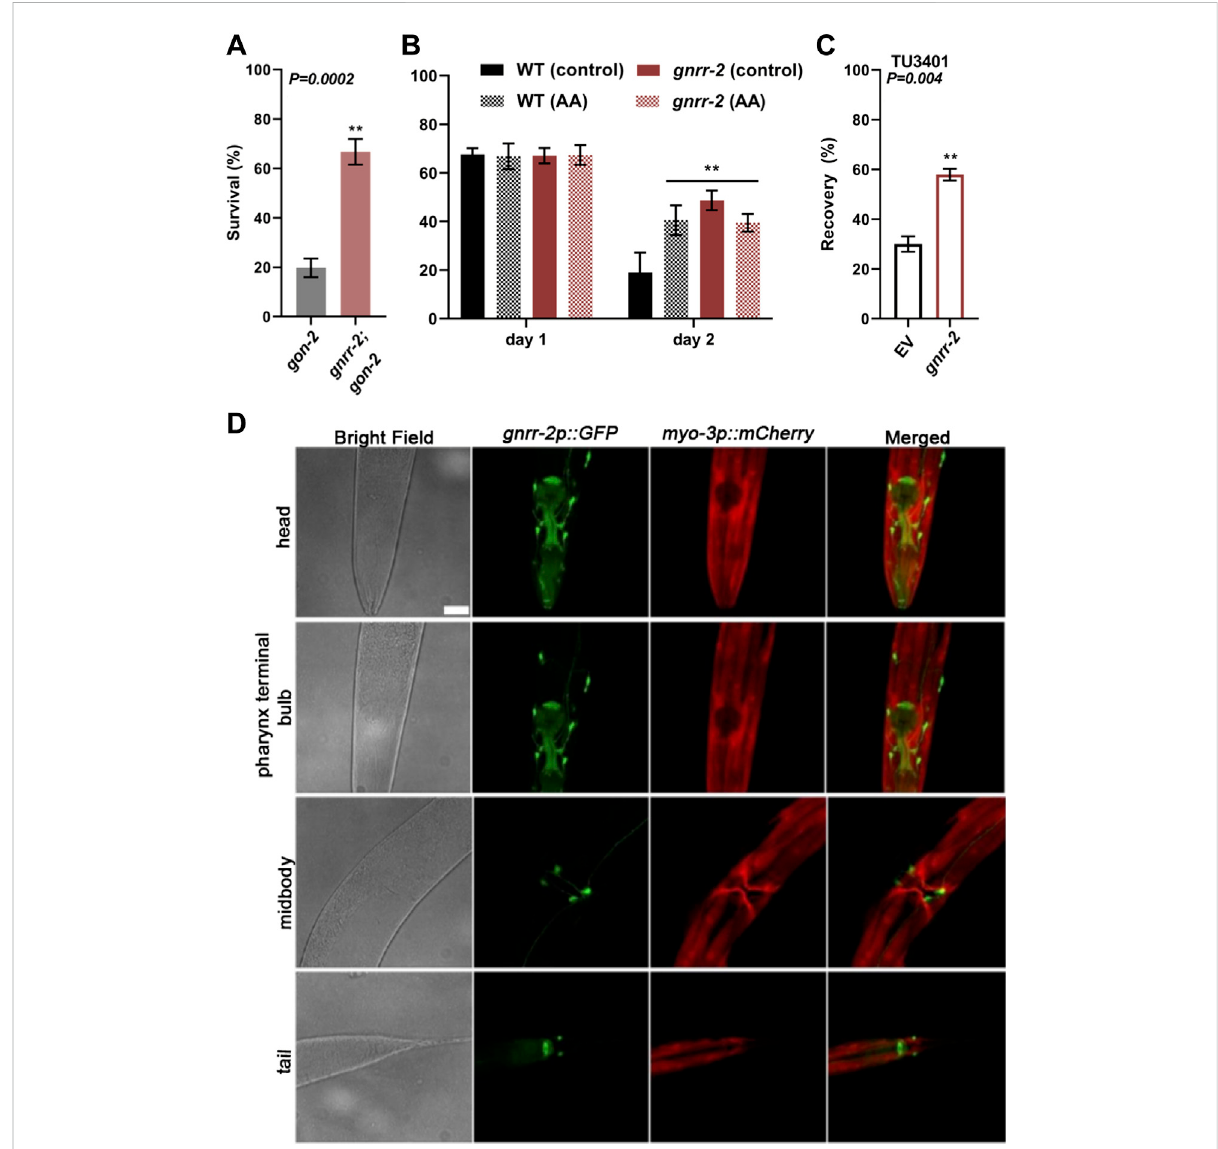
FIGURE 4 gnrr-2 isexpressedinthesoma andfunction downstream ofthegonad. (A) HSSurvivalratesofage-synchronized gon-2 ( q388 )or gnrr-2 ; gon- 2 mutant animals. Day two adults were subjected to HS (6 h at 37 ° C), and survival was assayed ( N ≥ 7). Data are means ±1 standard error of the mean (1 SE). Data were analyzed using the Wilcoxon Mann-Whitney rank sum test ( p = 0.0002). (B) HS Survival rates of age-synchronized WT or gnrr-2 mutantanimalsgrownoncontrolorarachidonicacid(AA)supplementedplates.AnimalsweresubjectedtoHS(6 hat37 ° C)ondayoneortwoof adulthood, and survival was assayed ( N ≥ 3). Data are means ±1 standard error of the mean (1 SE). Data were analyzed using one-way ANOVA followedbyaTukey ’ s post-hoc test.(**)denotes p ≤ 0.006comparedwithsame-ageWTcontrolanimals. (C) HSrecoveryratesofage-synchronized neuronal RNAi hypersensitive animals fed on empty vector (EV) or gnrr-2 RNAi-expressing bacteria. Day three adults were subjected to HS (4 h